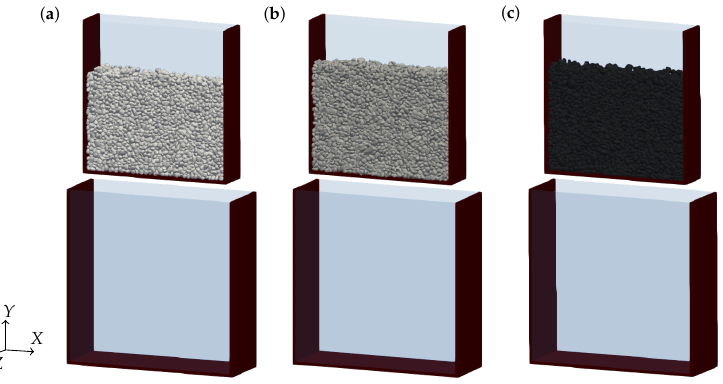
Figure 3. Geometries of the DDT DEM models with 4 polyhedral particles: ( a ) quartz, ( b ) granite and ( c ) coal. Each model has their own particle shape, particle size distribution and material properties. The setup of the DEM simulation corresponds to two processes: feeding and emptying.